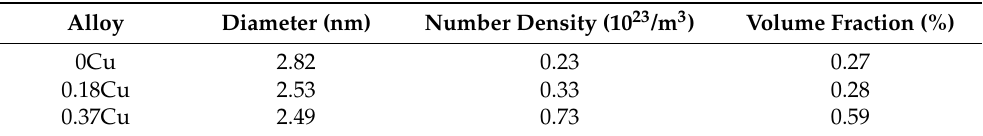
Table 5. Statistical information of GP zones of the alloys after aging at 175 °C for 0.5 h. Alloy